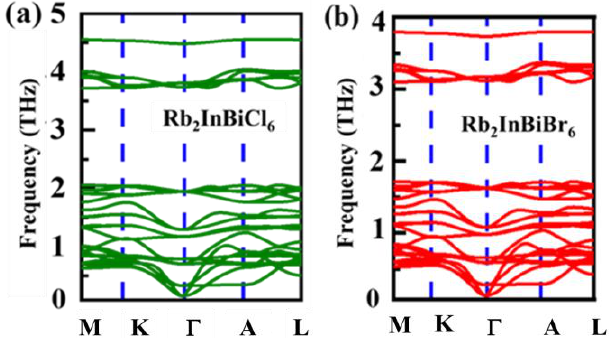
Figure 2. ( a , b ): Phonon dispersion plots for ( a ) Rb 2 InBiCl 6 and ( b ) Rb 2 InBiBr 6